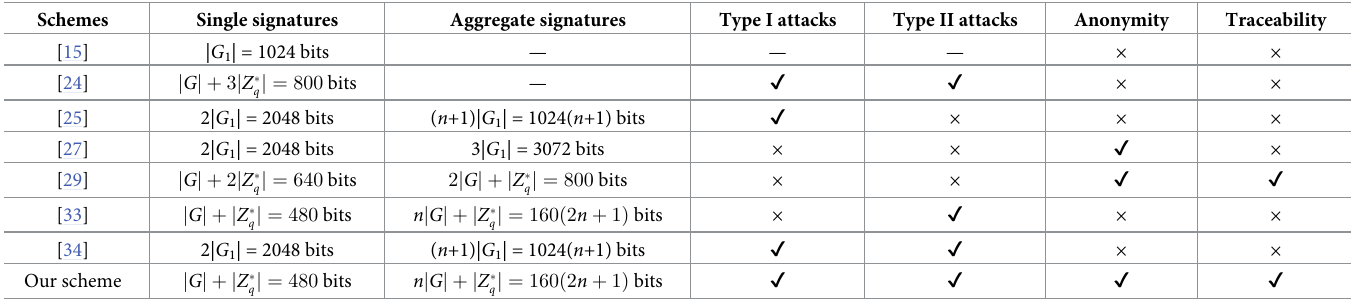
Table 5. Comparison of communication overhead and security